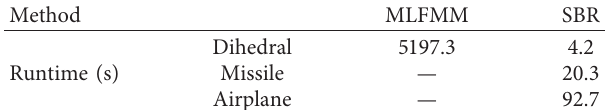
Table 1: Summary of runtime